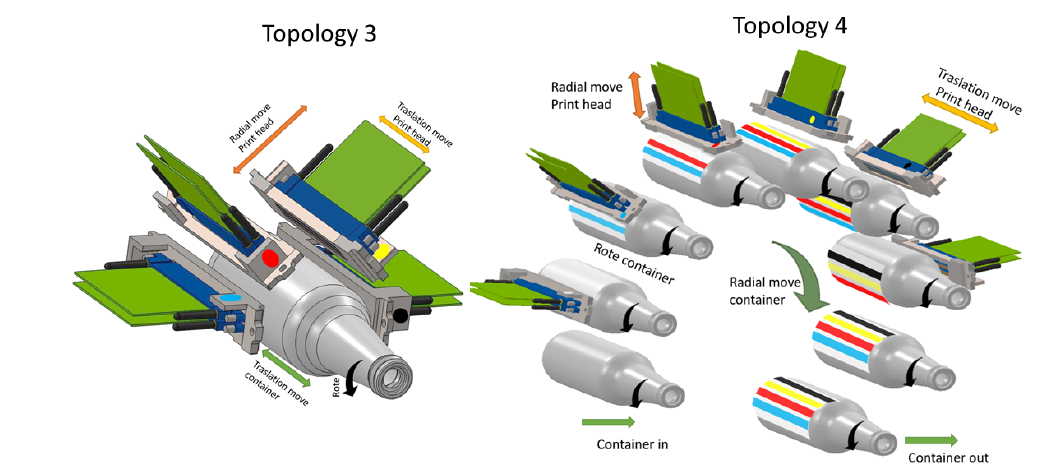
Figure 6. Topology 3 and